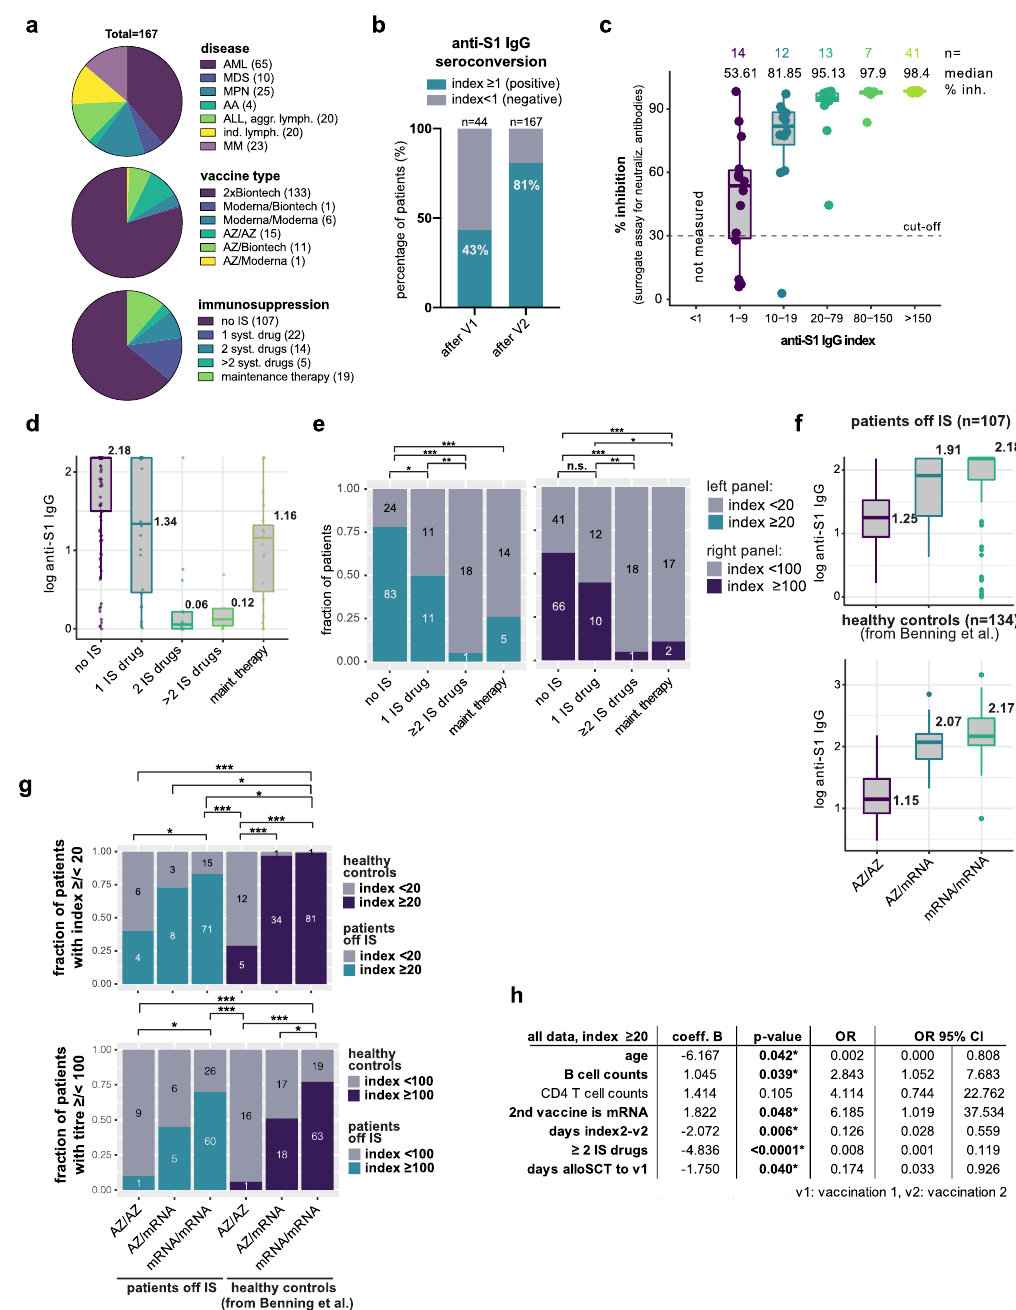
Figure 1. Humoral responses after COVID-19 vaccination in 167 post alloSCT patients. ( a ) Pie charts visualizing the distribution of disease types (above), vaccine types (middle), and number of IS agents employed (below) in the total cohort of 167 patients post alloSCT. Patients on IS (n = 41) were grouped according to the number of systemic drugs applied and comprised cyclosporine A serum level > 50µg/L, tacrolimus or sirolimus serum level > 3µg/L, any dose of corticosteroid, mycophenolate mofetil (MMF), or ruxolitinib. Topical treatment and extracorporeal photopheresis were not considered; ( b ) Bar graph displaying the fraction of patients achieving seroconversion defined as anti-S1 IgG index ≥ 1 after the first (n = 44) or second (n = 167) vaccination. v1: first vaccination, v2: second vaccination. ( c ) Percent inhibition determined by a surrogate virus neutralization test to estimate the amount of neutralizing antibodies in sera of patients with anti-S1 IgG ≥ 1. Patients were grouped according to anti-S1 IgG response. In this cohort, all patients with an anti-S1 IgG > 20 reached the cutoff of 30% inhibition (see methods for details). Numbers on the top indicate